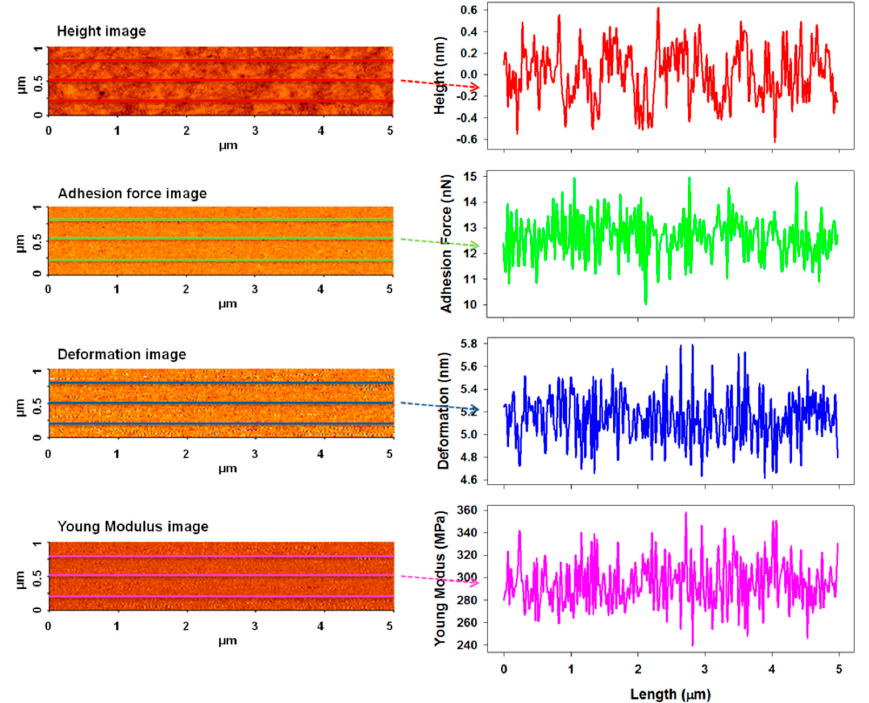
Figure 6. AFM PinPoint combined height, adhesion force, deformation, and Young’s modulus images and representative cross-section profiles taken along the middle line obtained for pristine azo-polyimide.